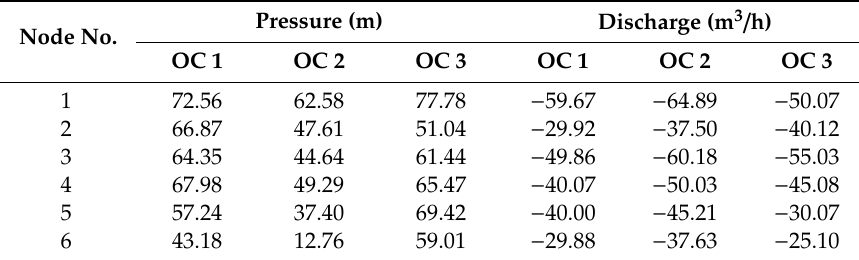
Table 3. Operating data with errors (error range = 1%).